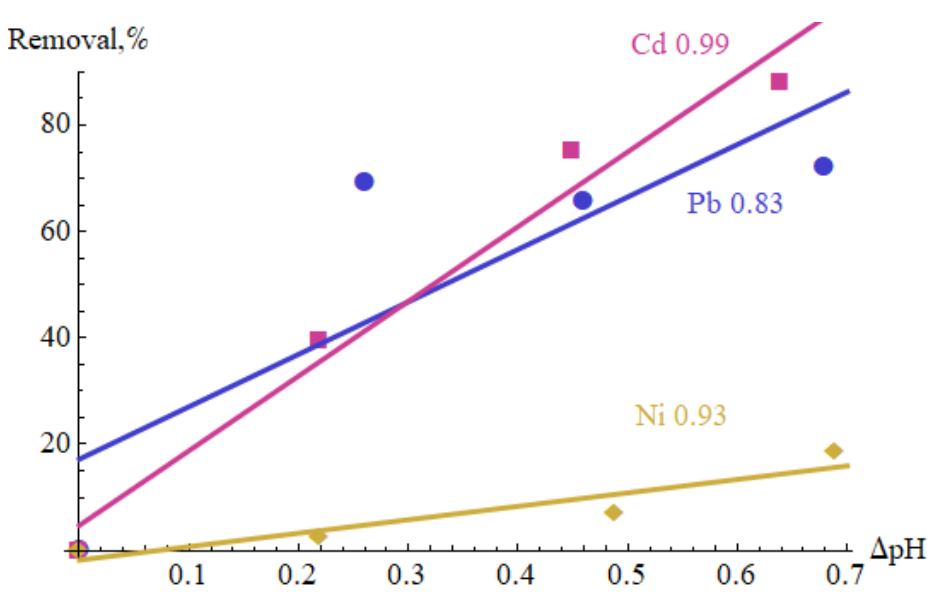
Figure 6. Correlations between pH changes and percentage removal versus number of cycles.